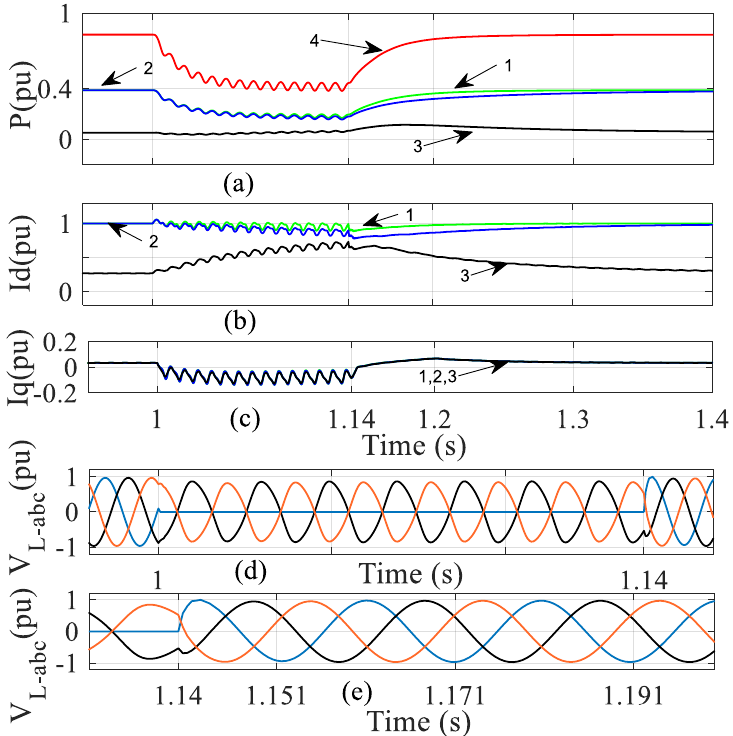
Figure 7. SLG fault. ( a ) Power from MGSCs (pu), 1 — P g 1 ; 2 — P g 2 ; 3 — P g 3 ; 4 — P g . ( b ) d -components of MGSC currents (pu), 1 — I d-g 1 ; 2 — I d-g 2 ; 3 — I d-g 3 . ( c ) q -components of MGSC currents (pu), 1 — I q-g 1 ; 2 —